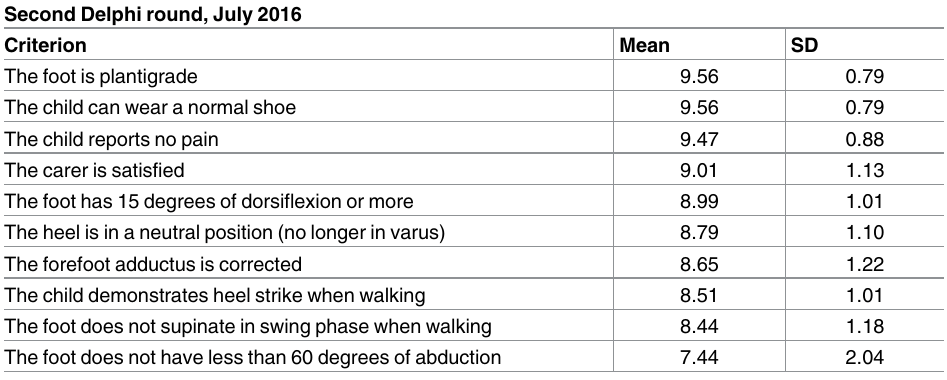
Table 2. Final rating of criteria in the second Delphi round (ordered by visual analogue scale mean and standard deviation). Second Delphi round, July 2016